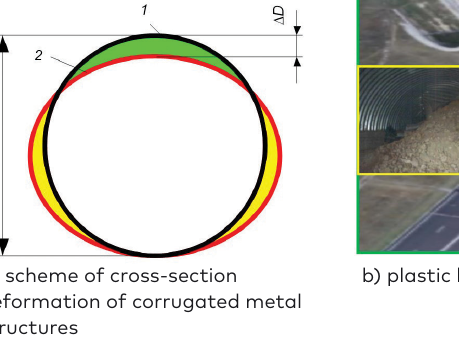
Figure 1. The roadbed destruction due to the plastic hinge defect in